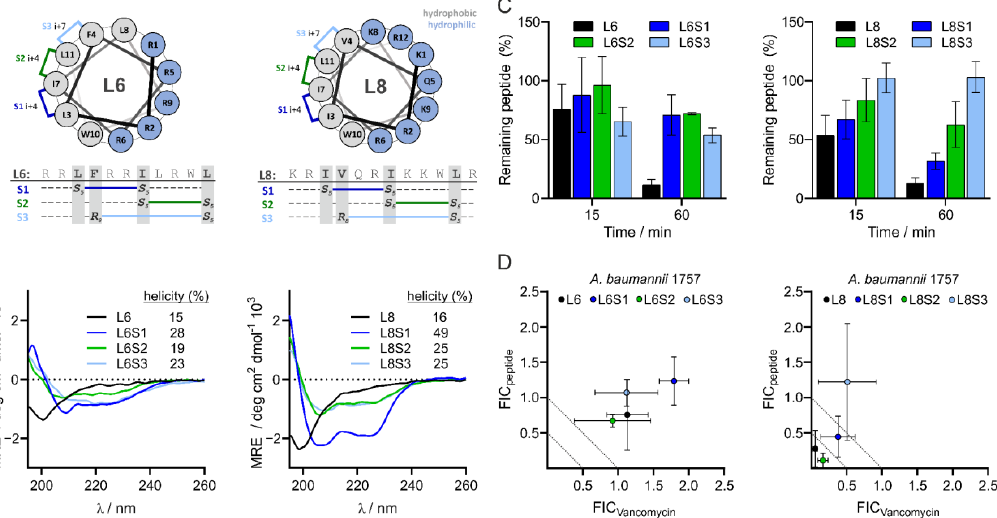
Figure 2. Design and properties of L6 and L8 as well as stapled versions. Design and structure of stapled L6 and stapled L8 ( A ). The degree of α -helicity of L6, L8 and the stapled variants of the peptides was determined with CD spectroscopy. Relative helicity was calculated using circular di- chroism analysis using neural networks (CDNN) software ( B ). Stability of L6, L8 and the stapled variants of the peptides in human serum were analyzed by LCMS and quantified using total ion count (TIC) of selected molecular ions ( C ). MIC values of the stapled peptides or vancomycin alone and MIC values of the stapled peptides combined with vancomycin or vancomycin in combination with the stapled peptides against Gram-negative bacteria were determined via checkerboard assay. The FIC values were defined as the ratio of either the MIC value of the stapled peptide in combina- tion with vancomycin over the MIC value of the stapled peptide alone (FIC L6 and FIC L8 ), or the ratio of the MIC value of vancomycin combined with the stapled peptide over the MIC value of vanco- mycin alone (FIC Vancomycin ) ( D ). The data are presented as mean ± standard deviation from three in- dependent experiments.